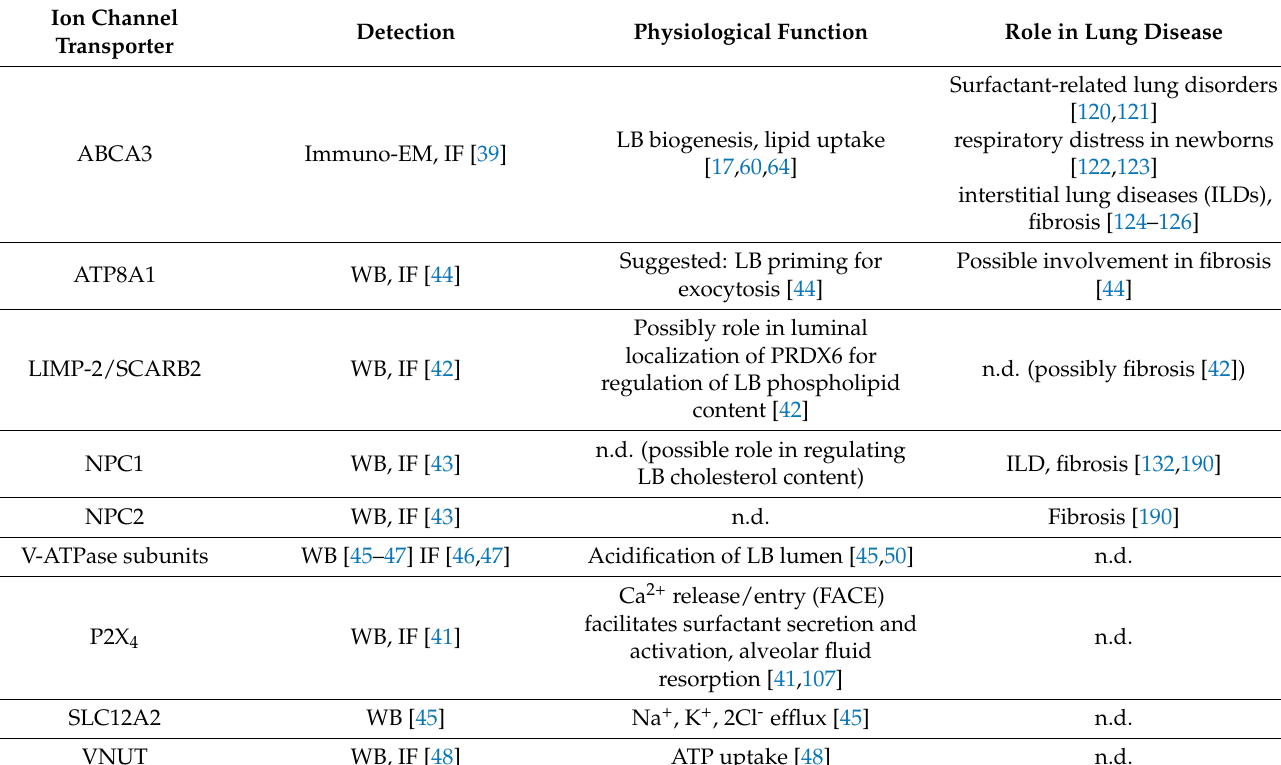
Table 1. Channels and transporters that have been identified on LBs and for which a function and/or a possible relevance in lung disease has been reported. The table does not list channels and transporters identified on LBs for which no physiological function has been described so